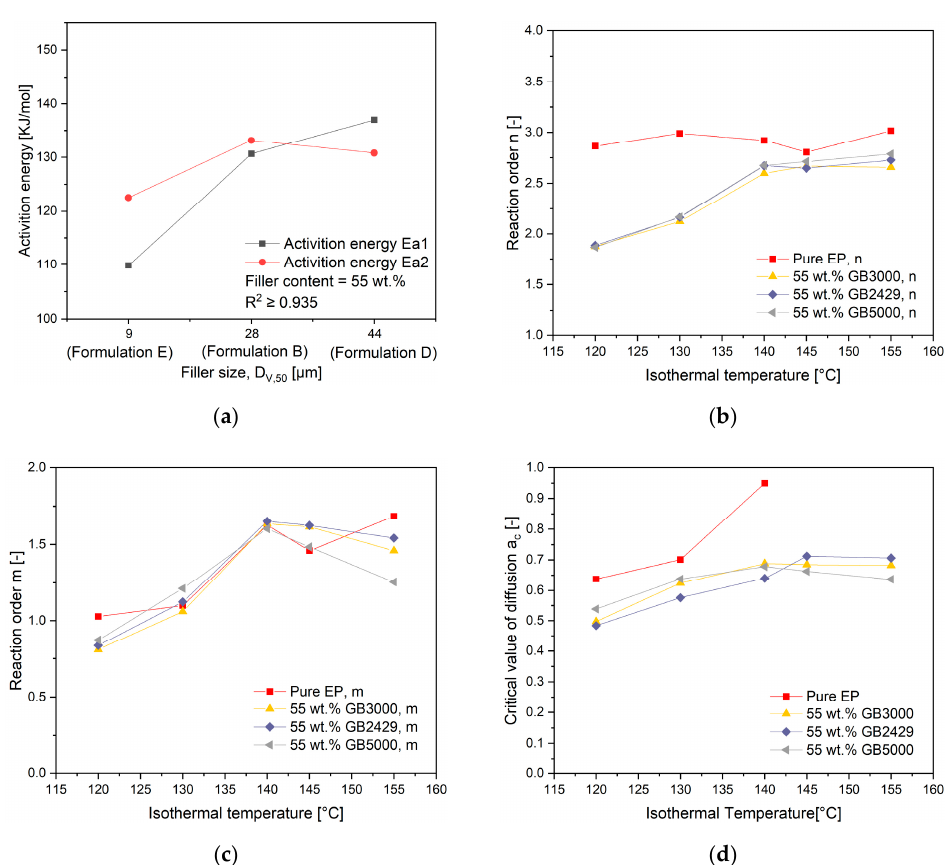
Figure 15. Influence of filler size on ( a ) activation energy ( b ) reaction order n for the n th order reaction ( c ) reaction order m for the autocatalytic reaction ( d ) critical value of diffusion a c